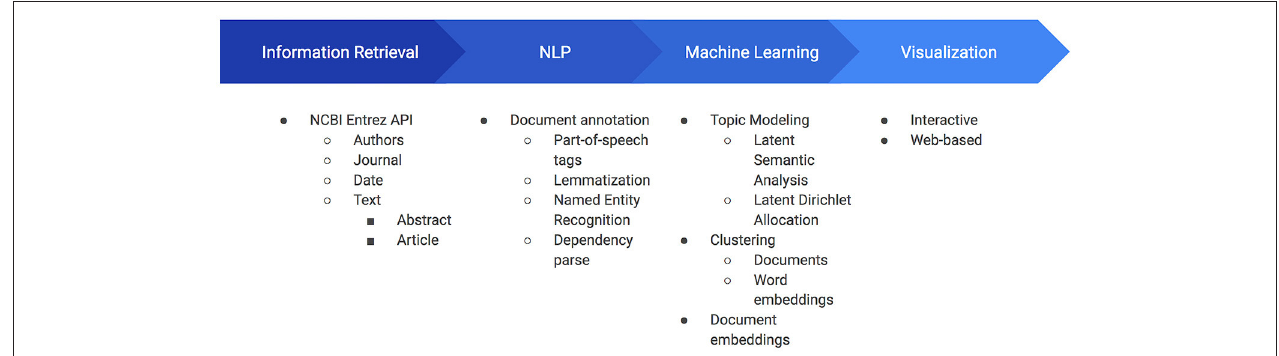
FIGURE 1 | Overview of SCKE’s four central building blocks and their components. Information retrieval is used to retrieve all documents and relevant metadata. Once retrieved, the documents are annotated and elements of the annotation are cached. These cached data are then used as input to several machine learning algorithms, which are finally visualized for researchers to interact with. Caching of processed documents and annotations permit SCKE to perform faster on subsequent invocations yielding the same